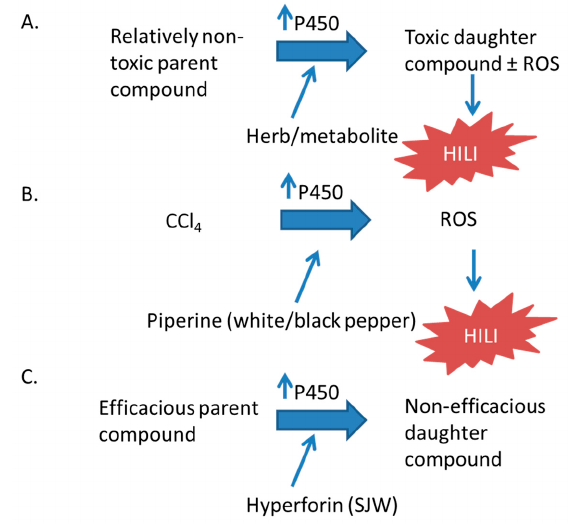
Figure 2. The effect of P450 inducers on toxicity. The parent compound can be the herbal supplement itself or a co-administered FDA-approved drug. ( A ) Schematic of the general mechanism; ( B , C ) specific examples discussed in the text [10–14].